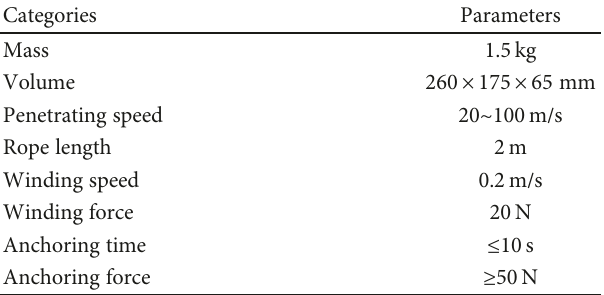
Figure 1: Schematic diagram and picture of the anchoring system. Table 1: Performance parameters of the anchoring system.